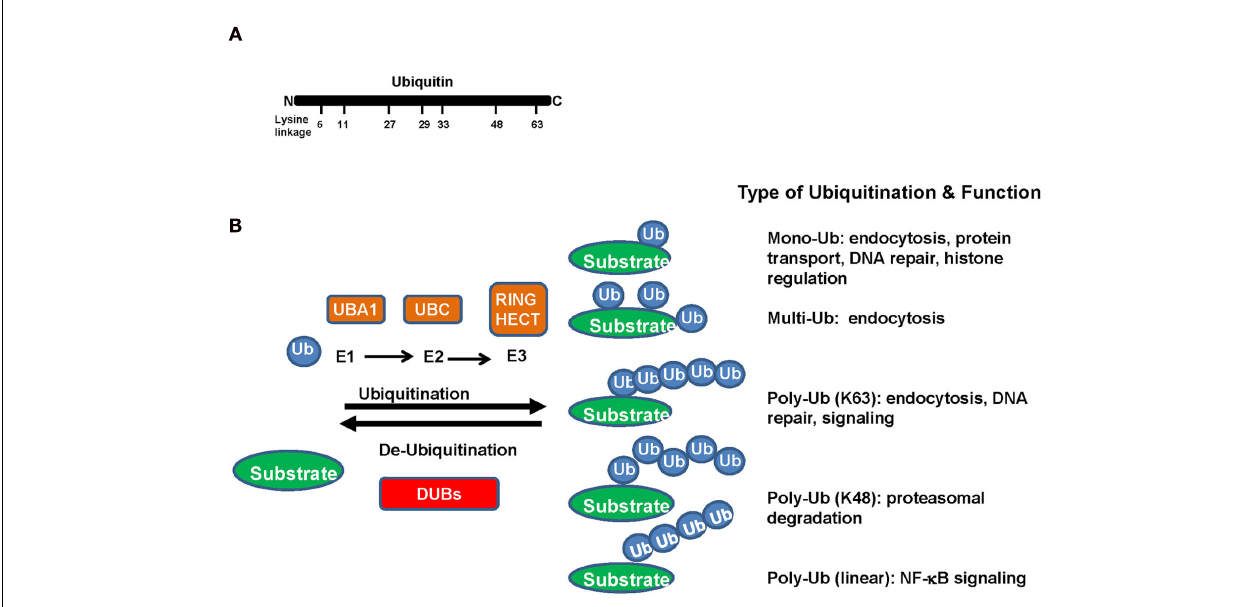
ubiquitin-activating enzyme (E1).The activated ubiquitin is then delivered to the ubiquitin-conjugating enzyme (E2), which will be transferred from the E2 to a lysine residue of a target protein by ubiquitin ligase (E3).The function usefulness of ubiquitin conjugation is not limited to the ubiquitin–proteasome pathway. Mono- and polyubiquitins are used as signals in various pathways including endocytosis, DNA repair, apoptosis, and transcriptional